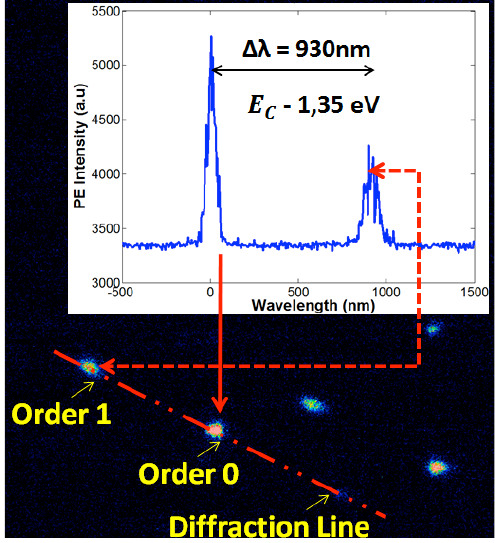
Fig. 7. Photo emission spectrum: Extracting a fresh device spot wavelength in the transistor mode (VGS, VDS) = (-7V, 50V).